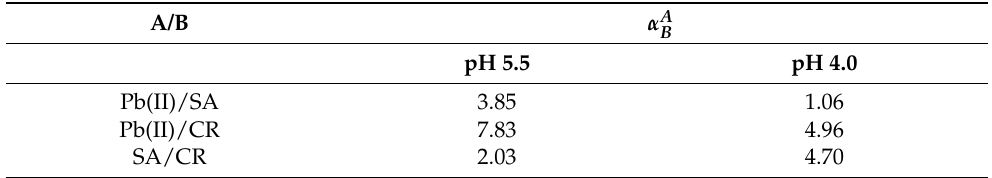
Table 5. Selectivity coefficients of the tested contaminants in the ternary